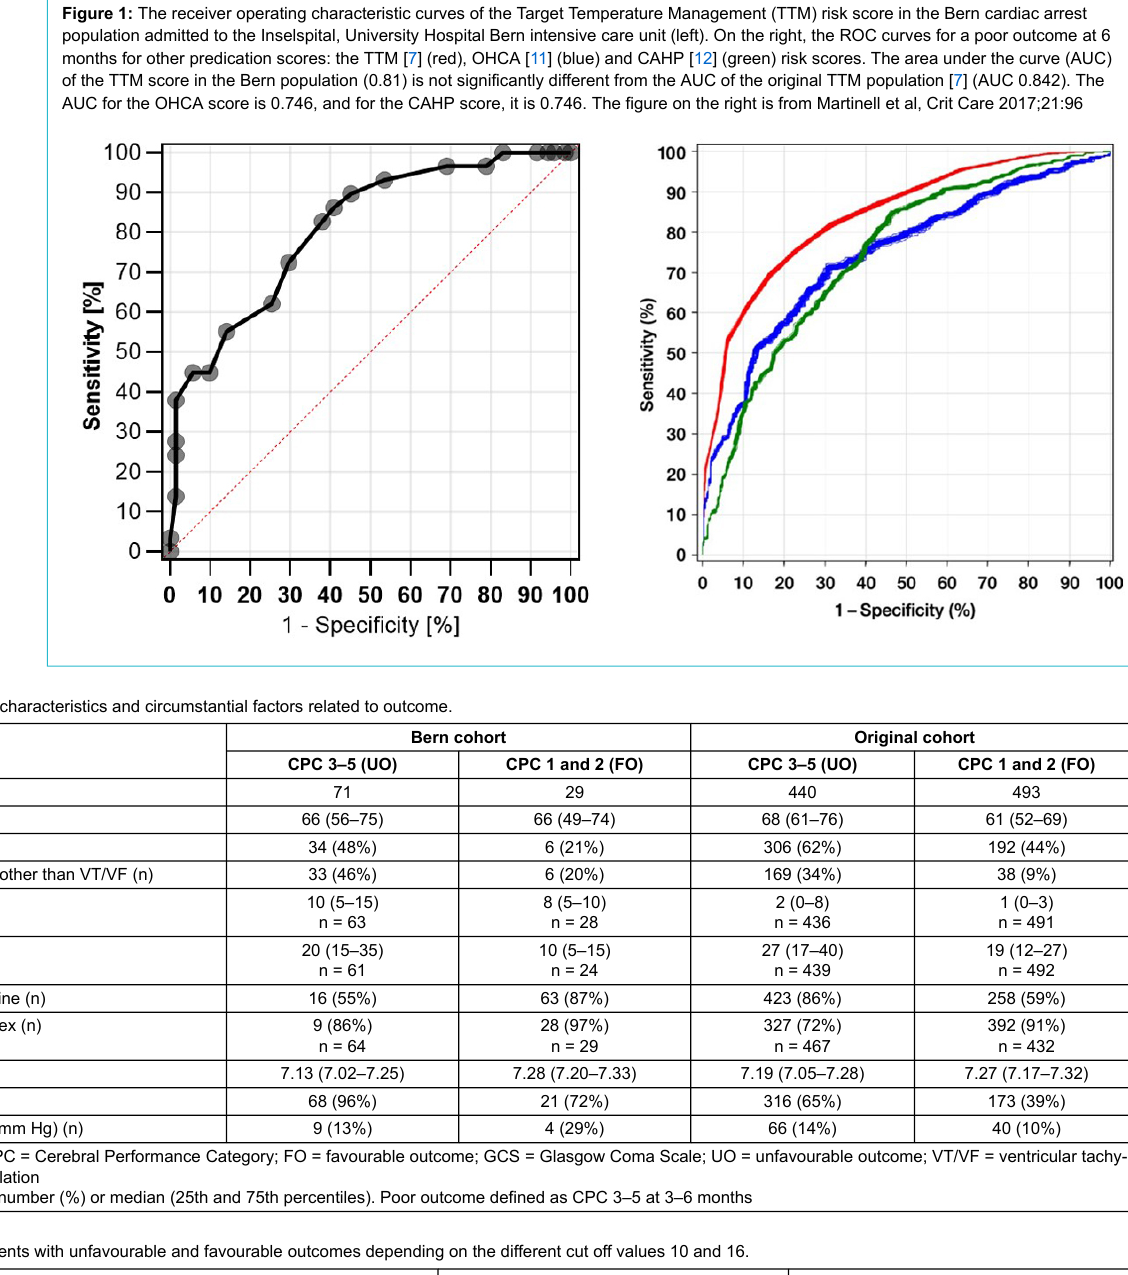
Table 2: Number of patients with unfavourable and favourable outcomes depending on the different cut off values 10 and 16.